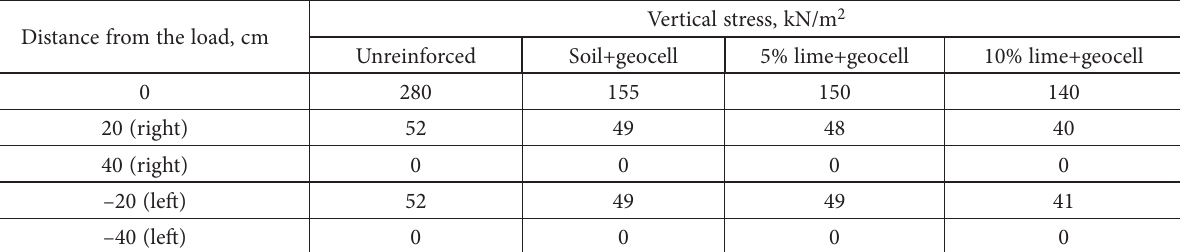
Table 4. Base soil stabilized with lime